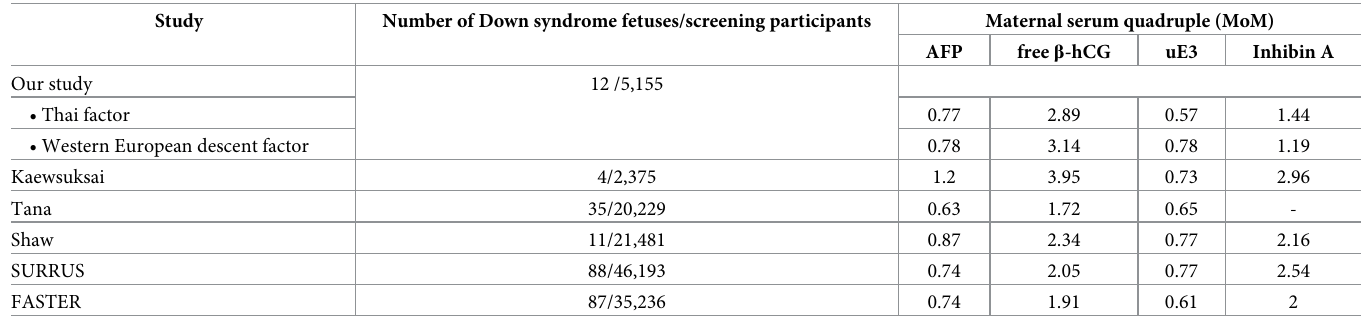
Table 4. Comparison of median MoMs in Down syndrome fetuses between different races and ethnicities.